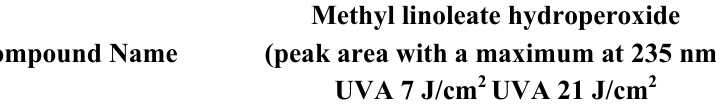
Table 1. Generation of methyl linoleate hydroperoxide by UVA irradiation of nitro-PAHs and PAHs in the presence of methyl linoleate